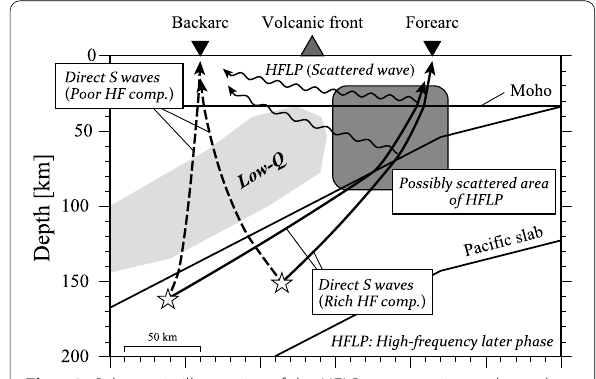
Fig. 10 Schematic illustration of the HFLP propagation paths and their relations to the heterogeneous structures in NE